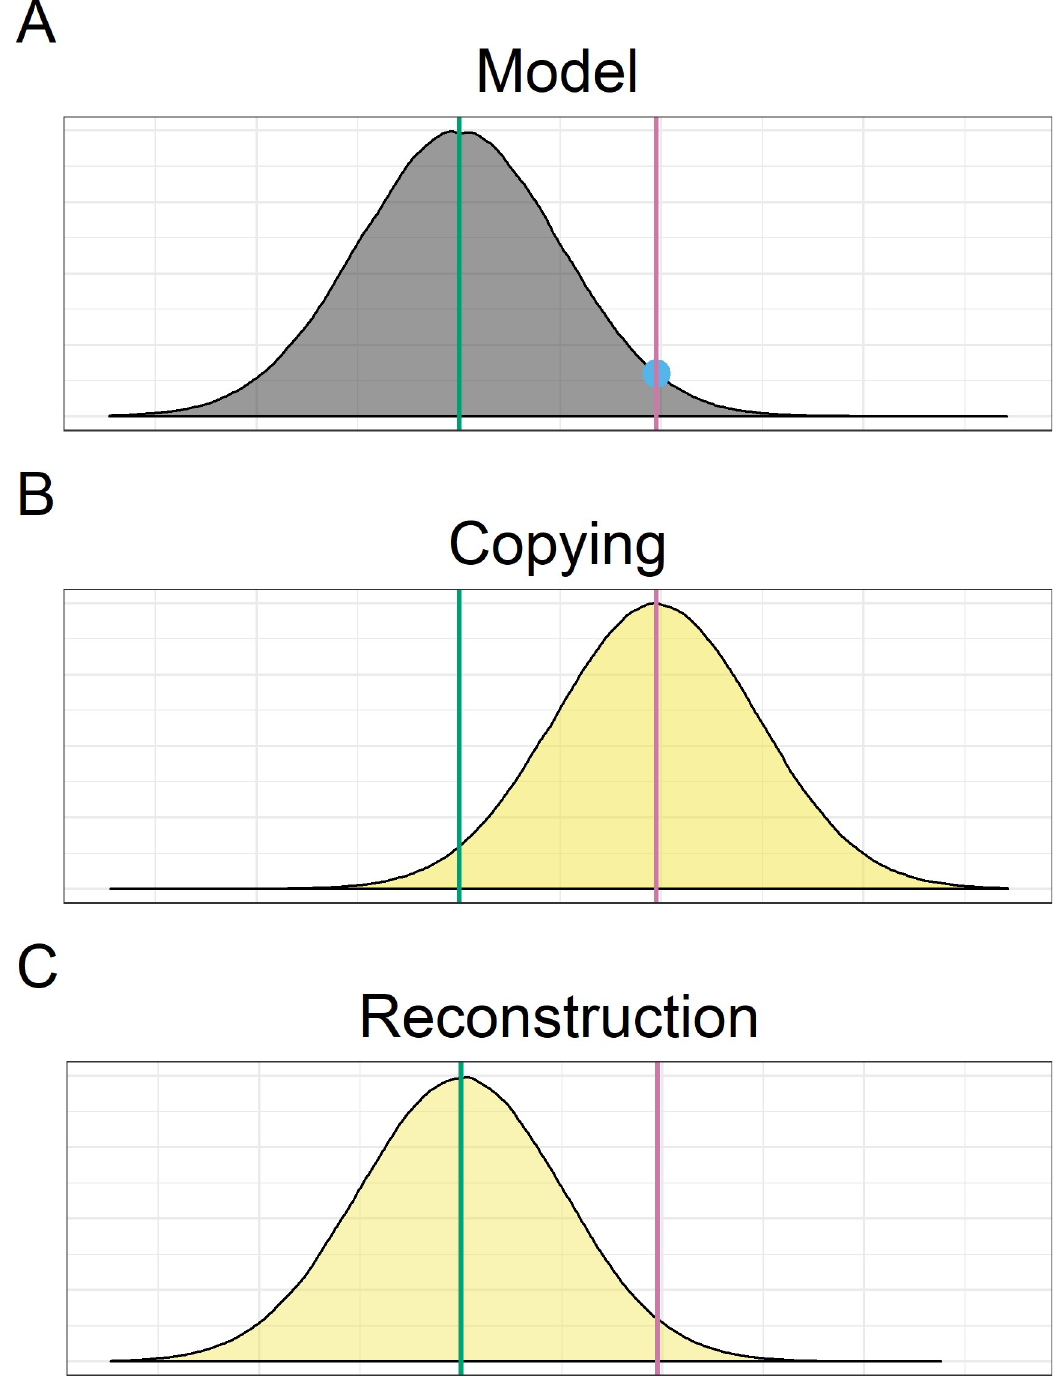
Fig 1. Predictions (A-C) of the copying and reconstruction account. A) A model’s behaviour follows a distribution (shown as normal for illustrative purposes only) centred on their representation of the to-be-transmitted information (Original; green line). By introducing deviation from this central representation through task instructions, the model produces a behaviour that falls away from the centre of this distribution (blue dot), which is passed on to the next generation (Learning; purple line). B) Under the copying account, participants will faithfully recreate what they see, introducing random copying errors. This will result in a distribution of behaviour (yellow) centred around the Learning action. C) Under the reconstruction account, participants will apply systematic transformations that converge back on the Original